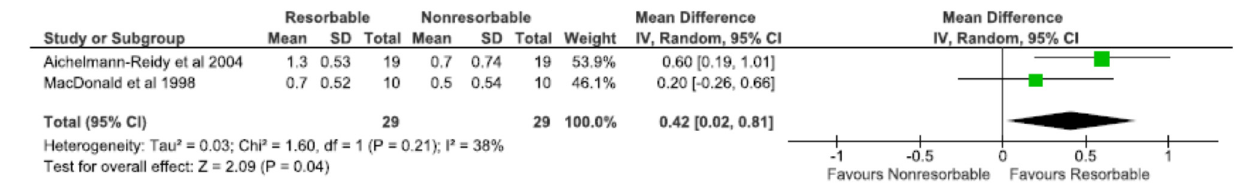
Figure 9. Meta-analysis of gingival recession (GRC) at 6 months.